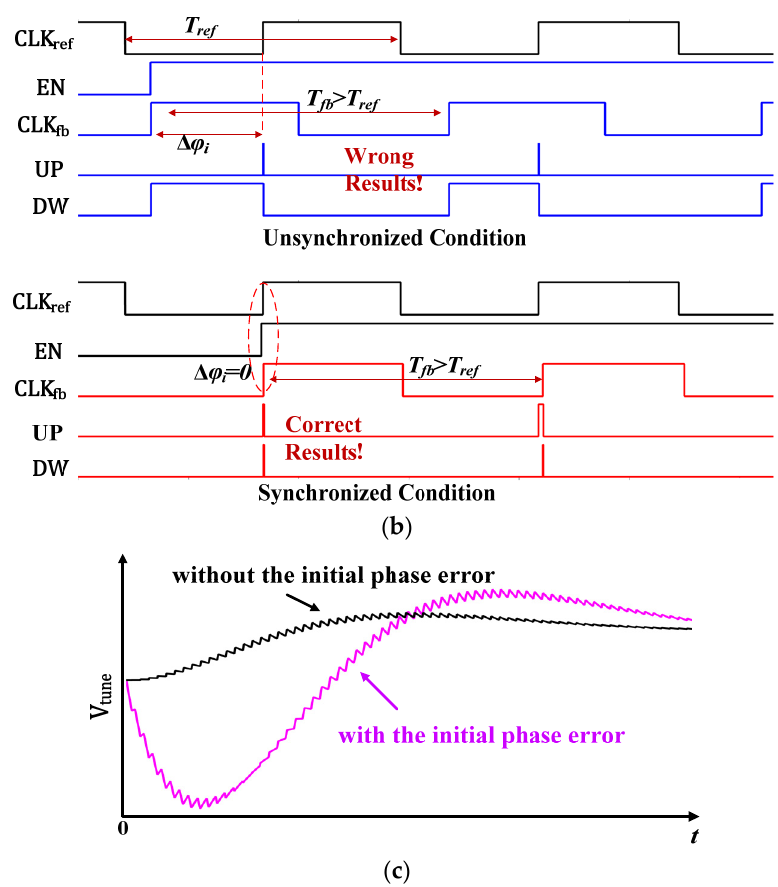
Figure 3. The challenges of conventional PLL ‐ based frequency calibration: ( a ) the schematic of the SR receiver with the PLL ‐ based calibration ( b ) the impacts of the unpredictable initial phase error on the phase error detection and ( c ) on the settling time of PLL.